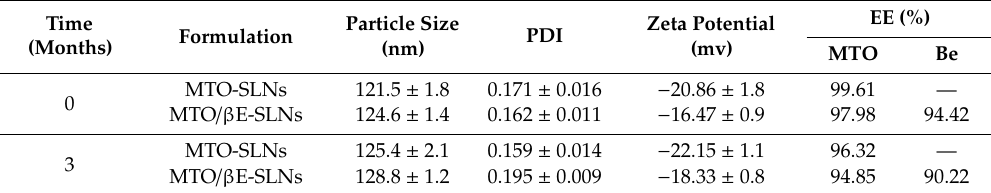
Table 2. The physicochemical characteristics and the stability at 4 ◦ C for three months of MTO-SLNs and MTO / β E-SLNs (mean ± SD, n =